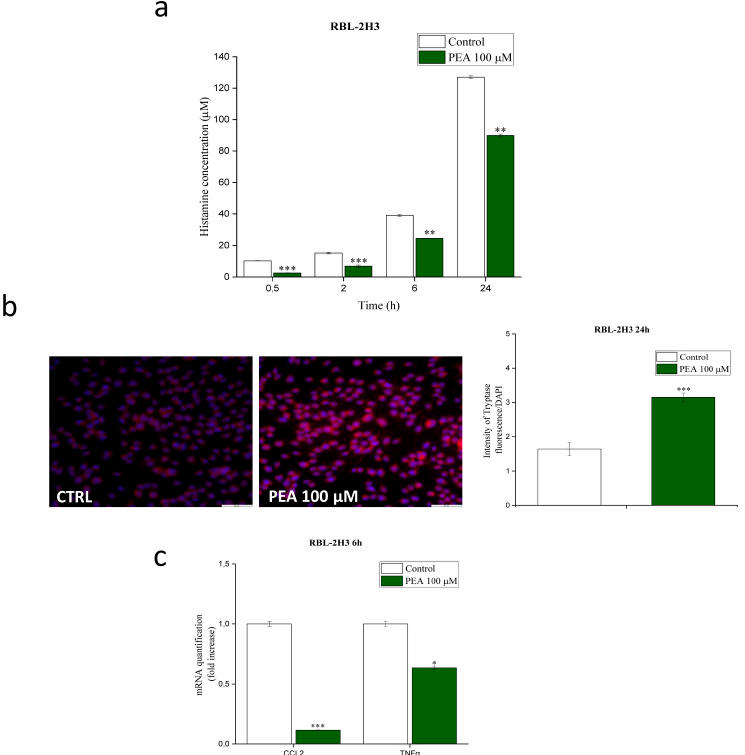
Figure 4. Long-lasting effect of PEA on MC degranulation. ( a ) Histamine concentration in the me- dium of RBL-2H3 cells pre-sensitized and pre-treated with PEA 100 μ M for 18 h and stimulated with DNP-BSA the next day for 30 min, 2, 6 and 24 h. ( b ) Immunofluorescence of tryptase on RBL- 2H3 cells pre-treated with PEA 100 μ M for 18 h together with the pre-sensitization, and the next day stimulated with DNP-BSA for 24 h. Cell nuclei were labeled with DAPI. Scale bar = 50 μ m. ( c ) RT- PCR of RBL-2H3 cells pre-sensitized and pre-treated with PEA 100 μ M for 18 h and the next day stimulated with DNP-BSA for 6 h. DNP-BSA was used at a final concentration of 625 ng/mL in all experiments. Control condition was arbitrarily set at 1, values are expressed as the mean ± S.E.M. of three experiments. * p < 0.05; ** p < 0.01; *** p < 0.001 vs. control.